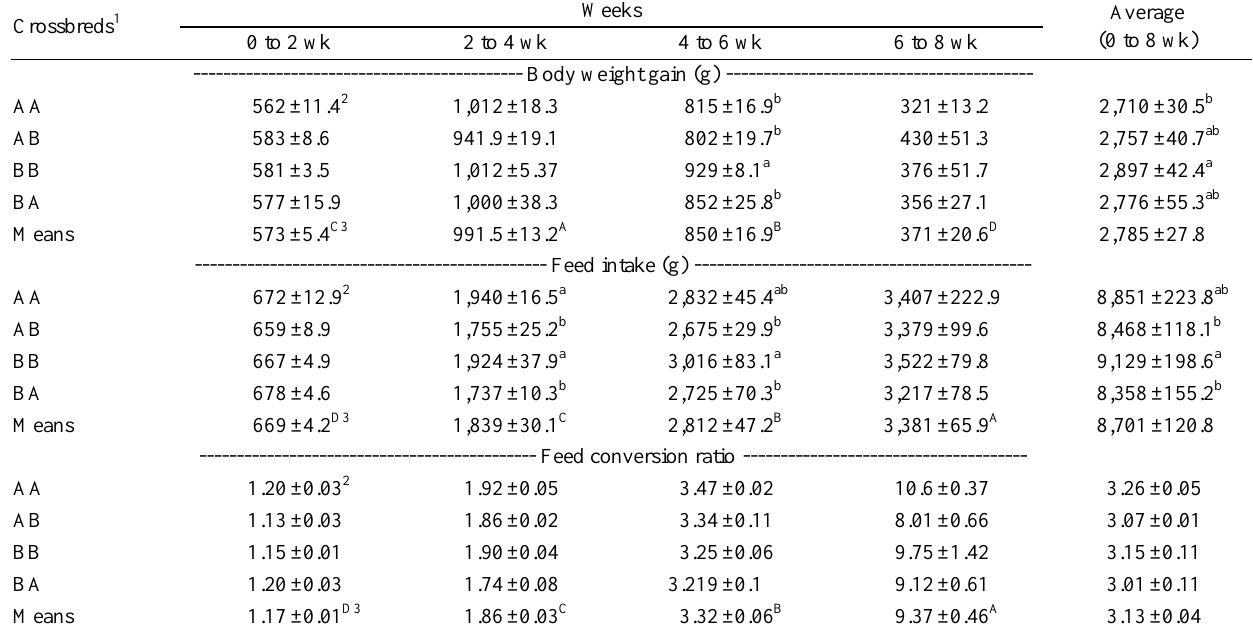
Table 5. Body weight gain, feed intake and feed conversion ratio of commercial Korean native ducks during experimental period Crossbreds